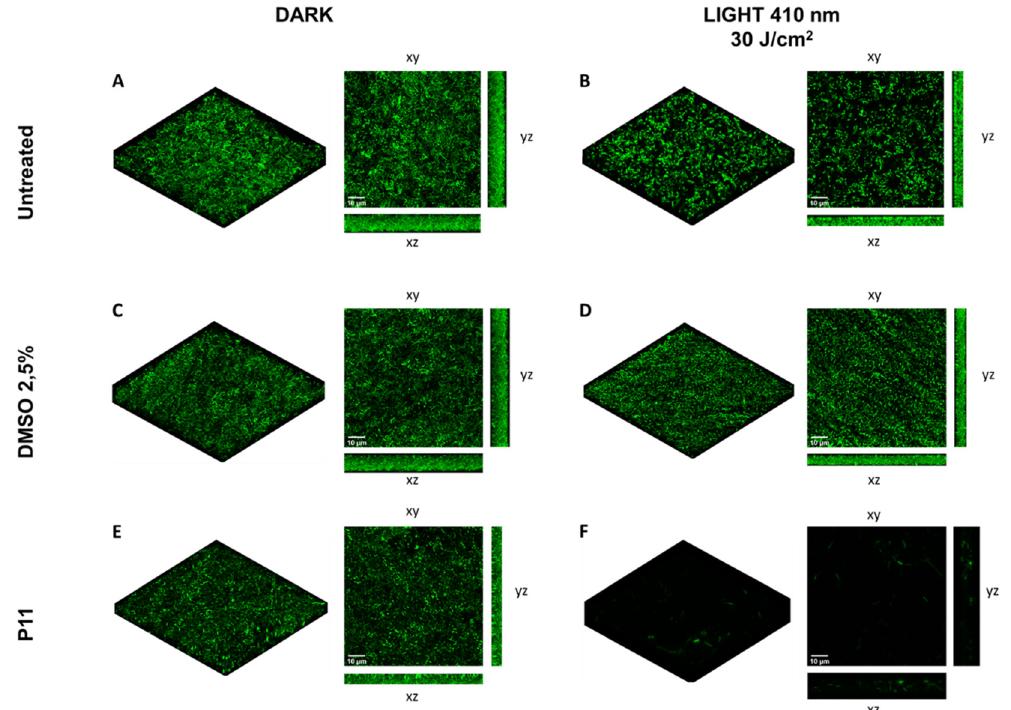
Figure 8. Assay of P. aeruginosa PAO1-GFP biofilm eradication with dicationic diaryl-porphyrin P11. A 24 h-old PAO1-GFP biofilm grown on coverslip glass was treated with P11 (30 µ M final concentration) and irradiated with 410 nm blue light at 30 J/cm 2 . Upon induction of GFP expression, confocal analyses have been performed. Biofilms (24 h) of untreated and DMSO-treated samples were included in the experiment. Dark controls are shown in panels ( A , C , E ), while irradiated samples are depicted in panels ( B , D , F ). Images of biofilms are shown in volume view, and in xy, xz and yz projections (scale bar = 10 µ